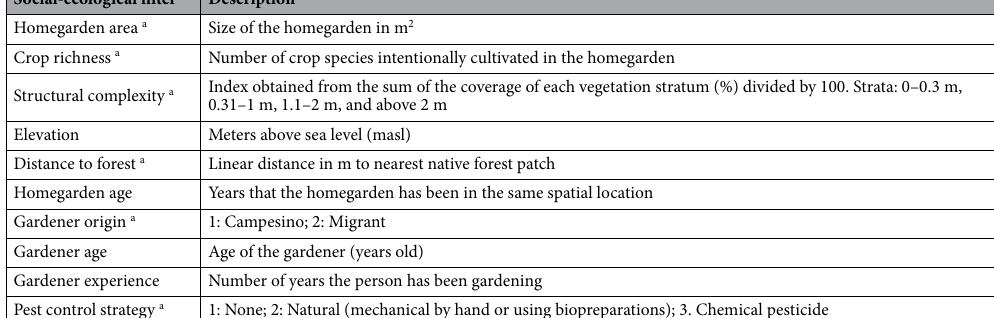
Table 2. Social-ecological filters used to evaluate homegarden associations of beetles (Arthropoda: Coleoptera) in Andean temperate ecosystems, southern Chile. a Social-ecological filters retained for tests of homegarden associations of beetles after reducing